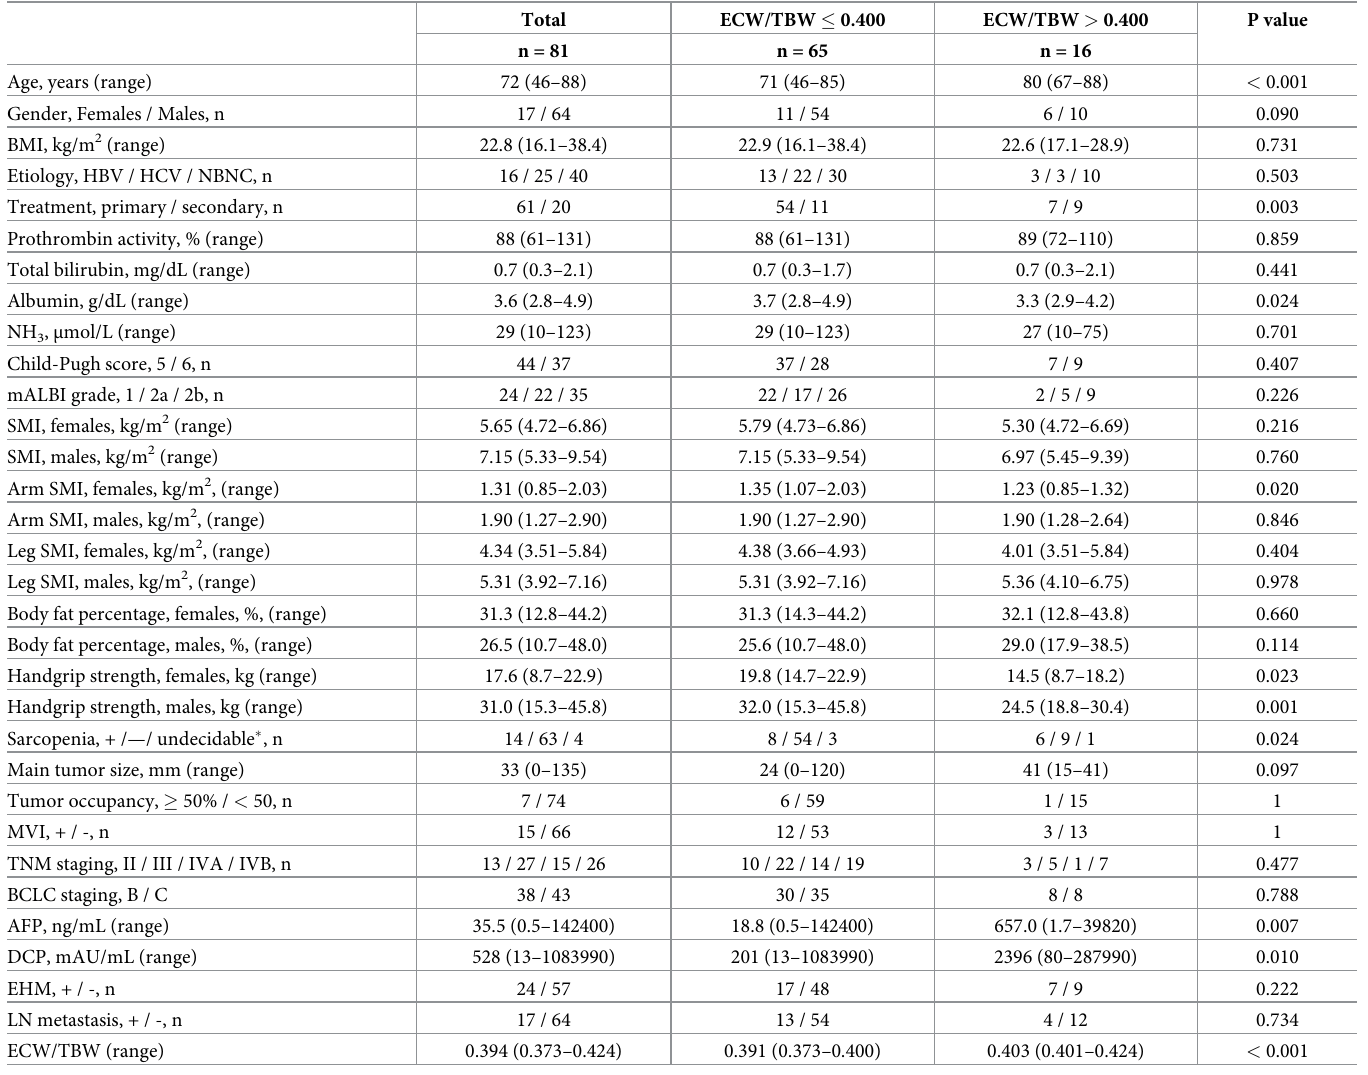
Table 1. Clinical background of patients treated with lenvatinib.